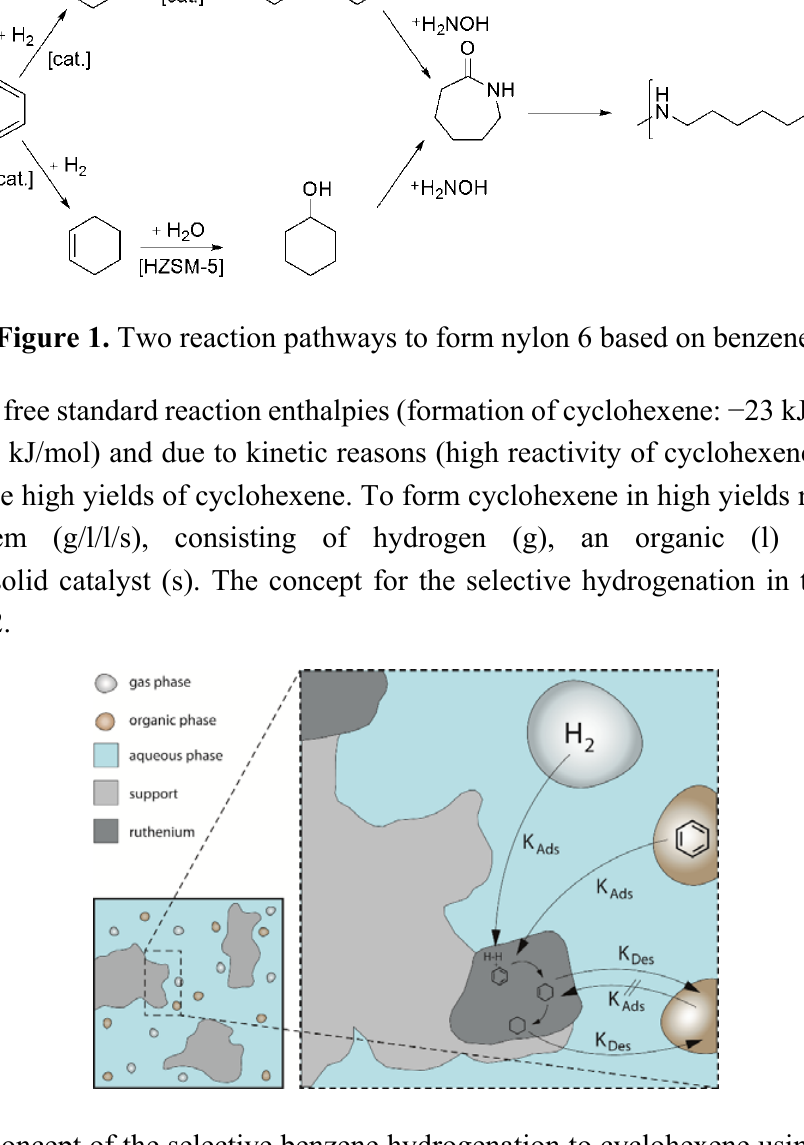
Figure 2. Concept of the selective benzene hydrogenation to cyclohexene using a complex tetra-phase system